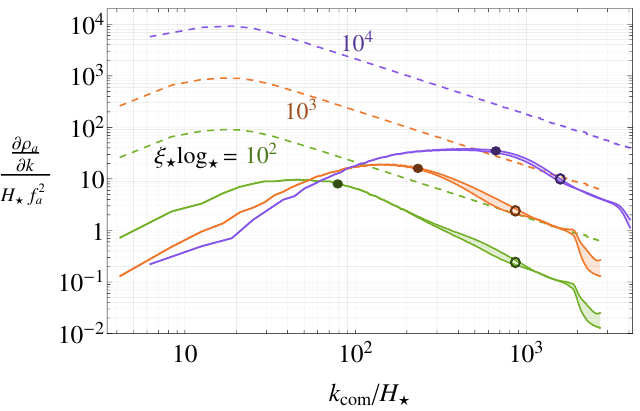
Figure 4: The axion energy density spectrum at H = H (cid:63) (dashed lines) and after the nonlin- ear transient (at the final simulation time H = H (orange) and 10 4 (purple), as a function of the comoving momentum k The lower and upper (solid) lines of the same color correspond to the results obtained with and without the oscillons masked. The unfilled dots show the comoving momenta corre- sponding to the physical momenta that are equal to the axion mass at the final time (i.e. = m ( t )( H / H ) 1 / 2 ). We also indicate the comoving momenta corresponding to the k (cid:63) a f f com physical momenta that are equal to the axion mass at t = t (cid:96) (i.e. k filled dots), which is parametrically the time when the nonlinear transient